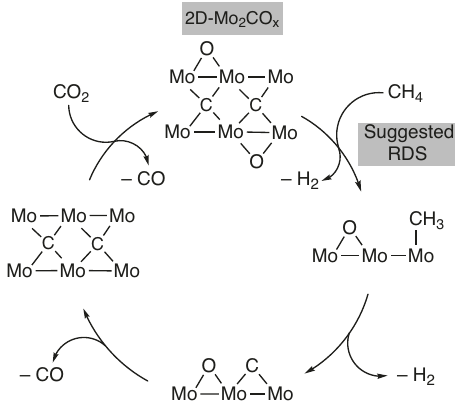
Fig. 4 A simpli fi ed proposed mechanism for the dry reforming of methane on 2D-Mo 2 CO x . The most active catalyst has a partial oxygen surface coverage, corresponding to Mo( + 4) oxidation state. The C – H bond activation of methane is proposed as RDS, i.e., rate determining step, based on